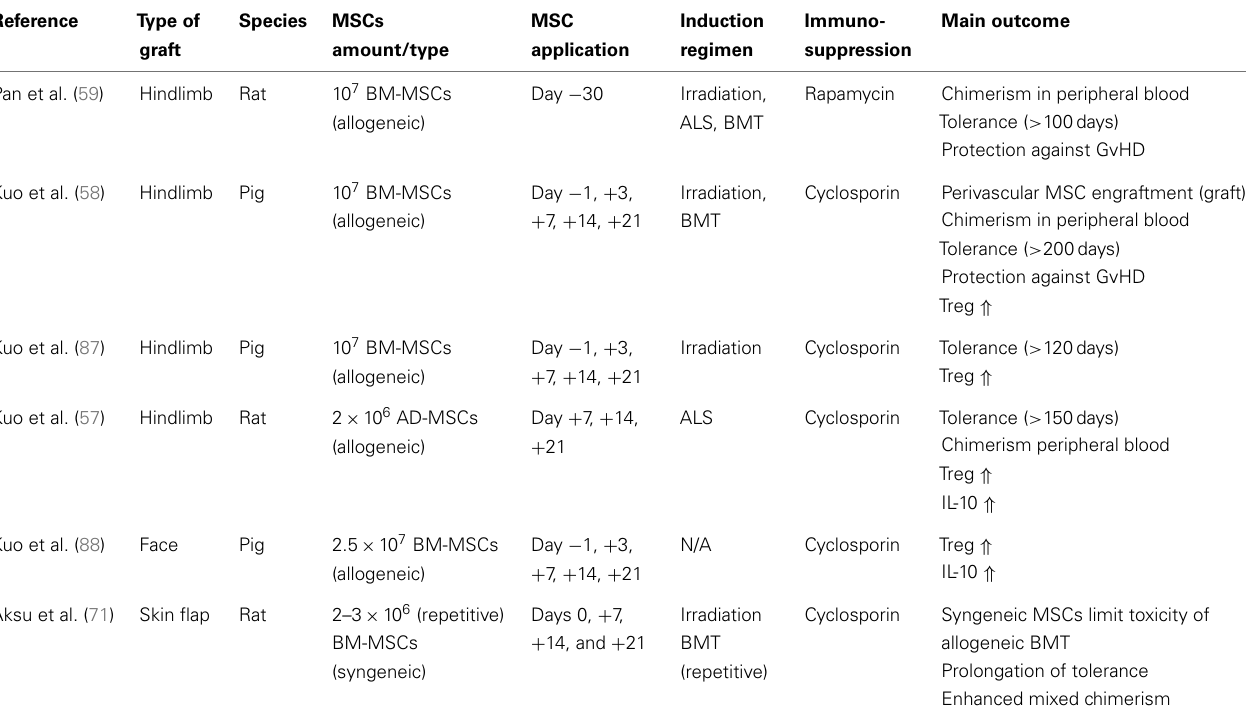
Table 1 | Overview of the currently available experimental literature on MSC based cellular therapy for immunomodulation inVCA.